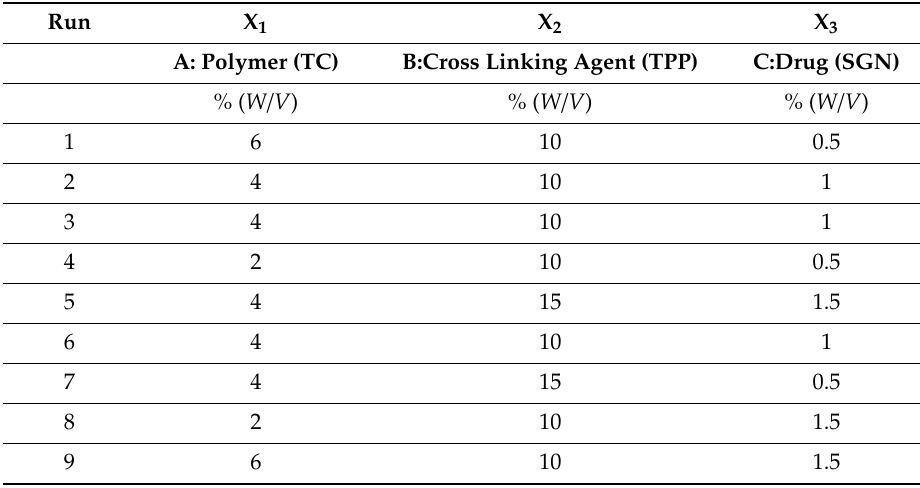
Table 2. The designed SNG–TC nanoparticles according to the Box-Behnken experimental design. Run X